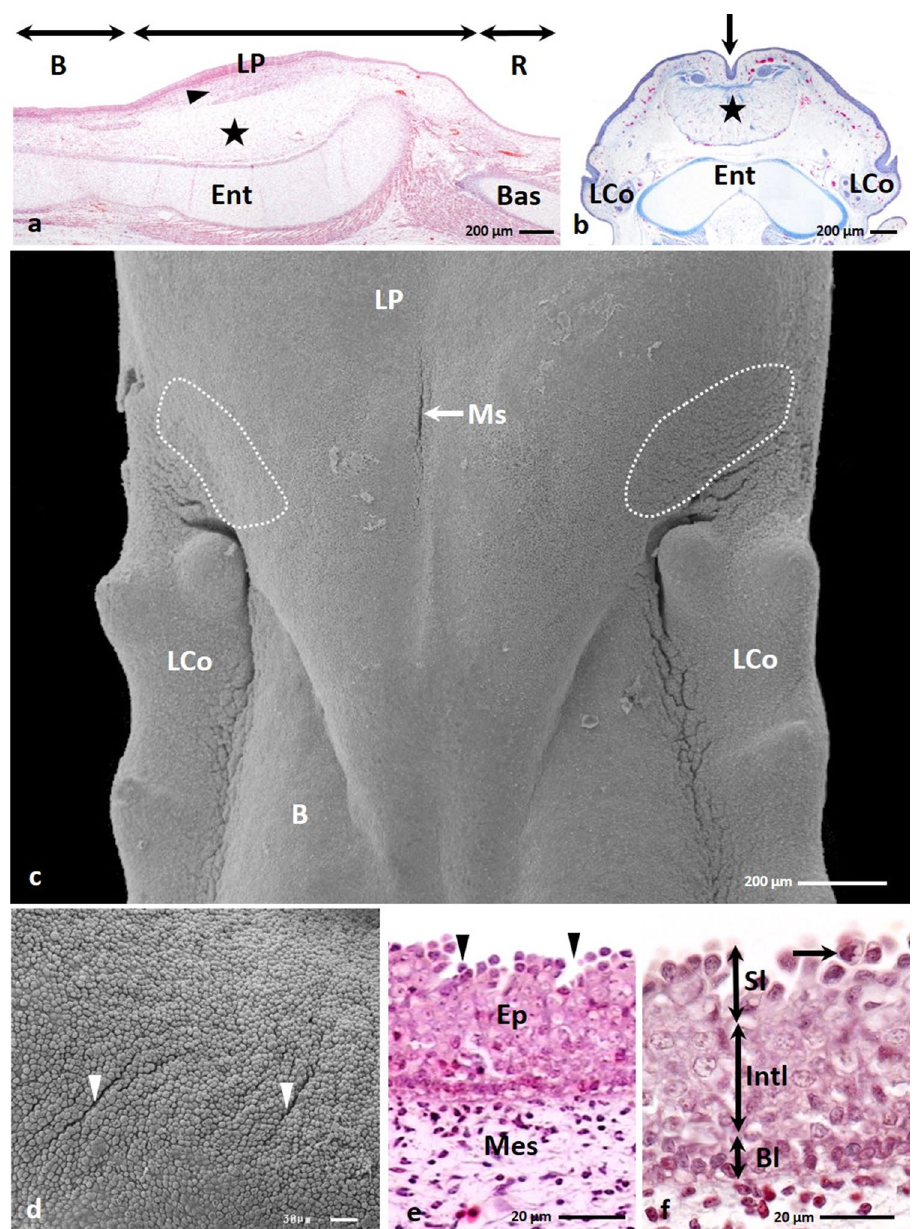
Figure 2. ( a ) 16th day of incubation. Cross section along the long axis of the caudal part of the body (B), lingual prominence (LP) and root of the tongue (R). Mesenchymal cells underneath the epithelium are densely arranged (arrow). Pre-adipocytes are present above the entoglossum cartilage (Ent) (asterisk). Bas-basihyale bone. LM. Masson–Goldner staining. ( b ) 18th day of incubation. Transverse cross section of the lingual prominence with median sulcus (arrow). Pre-adipocytes form an oval band (asterisk) over the entoglossum cartilage (Ent). LCo-primordium of the large conical papillae. LM. Masson–Goldner staining. ( c ) 16th day of incubation. View of the dorsal surface of the triangular lingual prominence (LP). On the lateral areas of the lingual prominence are present oval in shape areas with superficial furrows (dotted lines). B-body of the tongue, LCo-primordium of the large conical papillae. SEM. ( d ) 16th day of incubation. Magnification of the lateral area of the lingual prominence with epithelial furrows arrange in parallel rows (arrow heads). SEM. ( e ) 16th day of incubation. Cross section of the epithelium (Ep) of the lingual prominence with furrows (arrow heads). Mes- mesynchyme. LM. Masson–Goldner staining. ( f ) 16th day of incubation. Higher magnification of the epithelium on the lingual prominence consists of the basal (Bl), intermediate (Intl) and superficial layer (Sl). The cell nuclei in the superficial cells have condensed chromatin and are irregular in shape (arrow). LM. Masson–Goldner